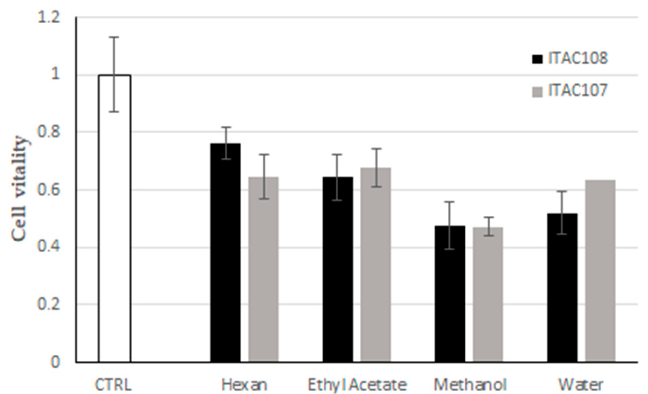
Figure 5. Effect of cyanobacterial fractions on cultured cells viability. The MTT assays was performed on human HeLa cells exposed for 6 h to cyanobacterial fractions from Synechococcus sp. ITAC107 and Cyanobium sp. ITAC108 strains.